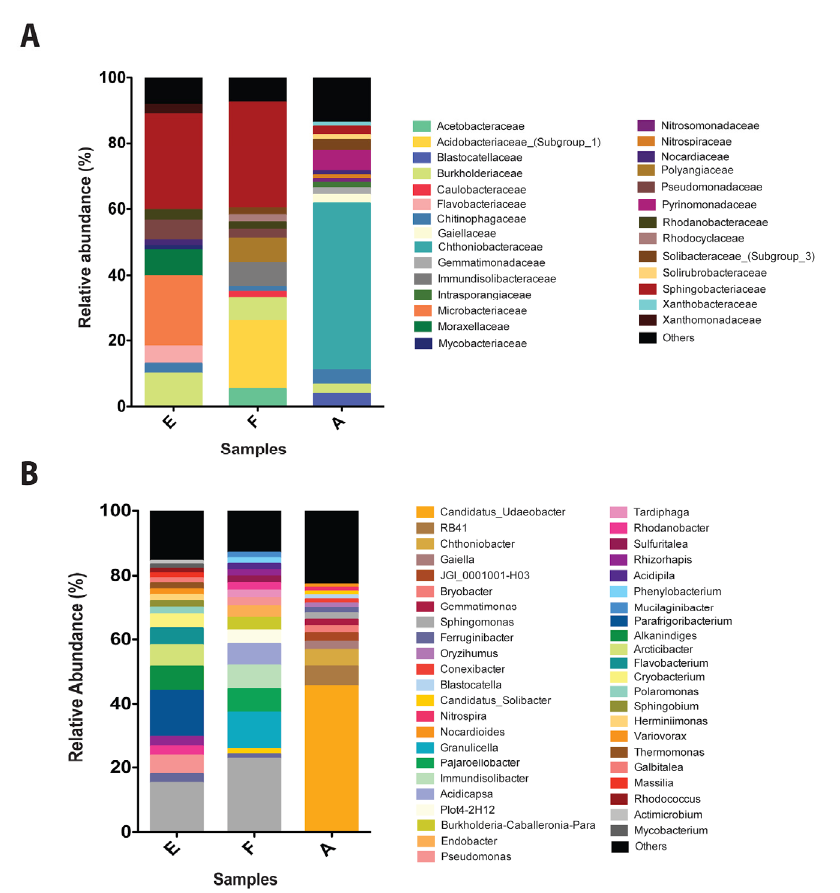
Figure 3. Bacterial communities in Antarctic soil samples exposed to diesel. ( A ) Relative abundance of the most representative families presents in Antarctic soil samples ( > 1%) non exposed (A, control) and exposed to diesel (E and F). ( B ) Relative abundance ( > 1%) of the most representative OTUs, classified by genus, present in Antarctic soil samples ( > 1%) non exposed (A, control) and exposed to diesel (E and F). Abundances below 1% were assigned as others.